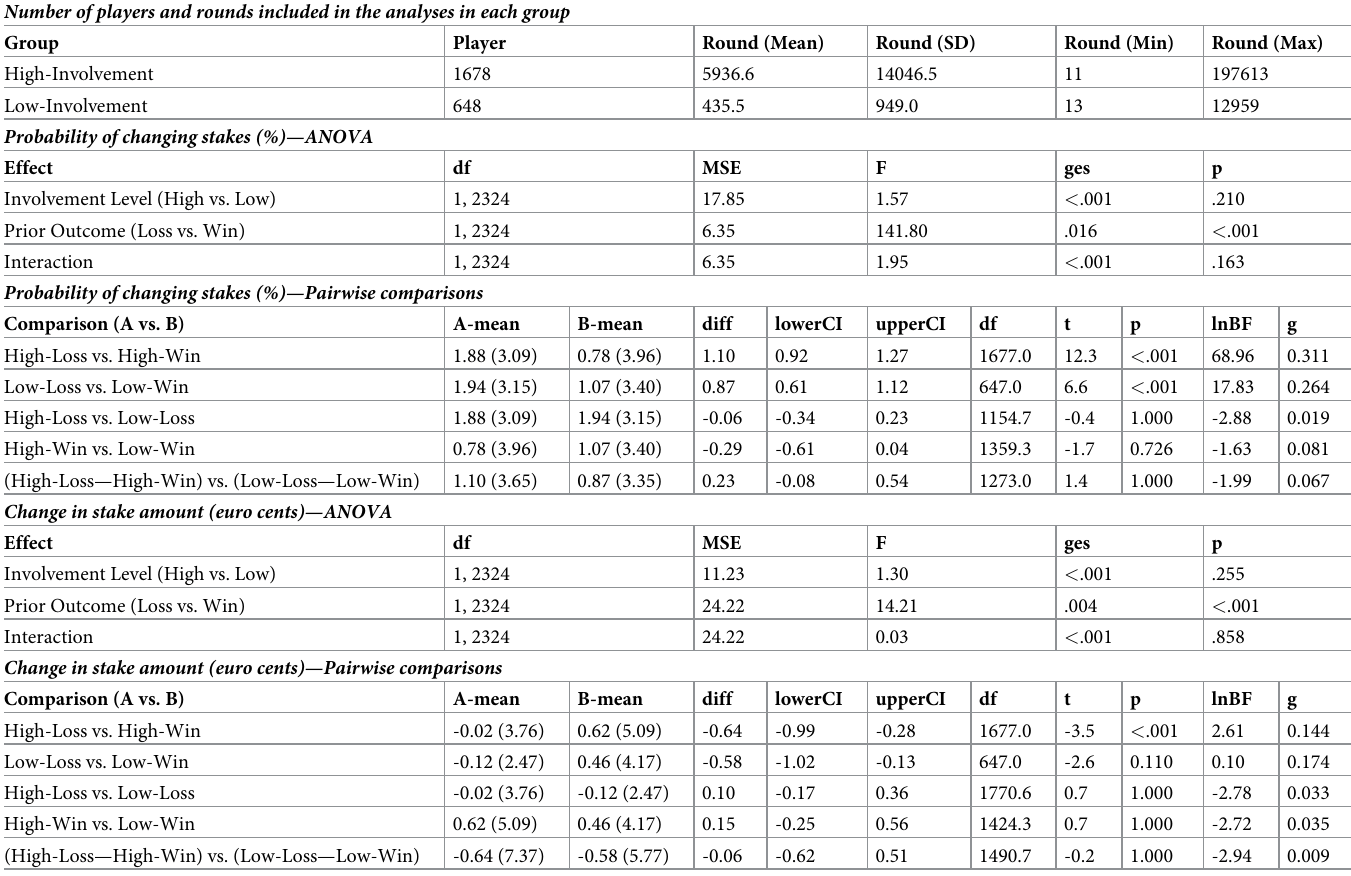
Table 5. Statistical analyses on change in